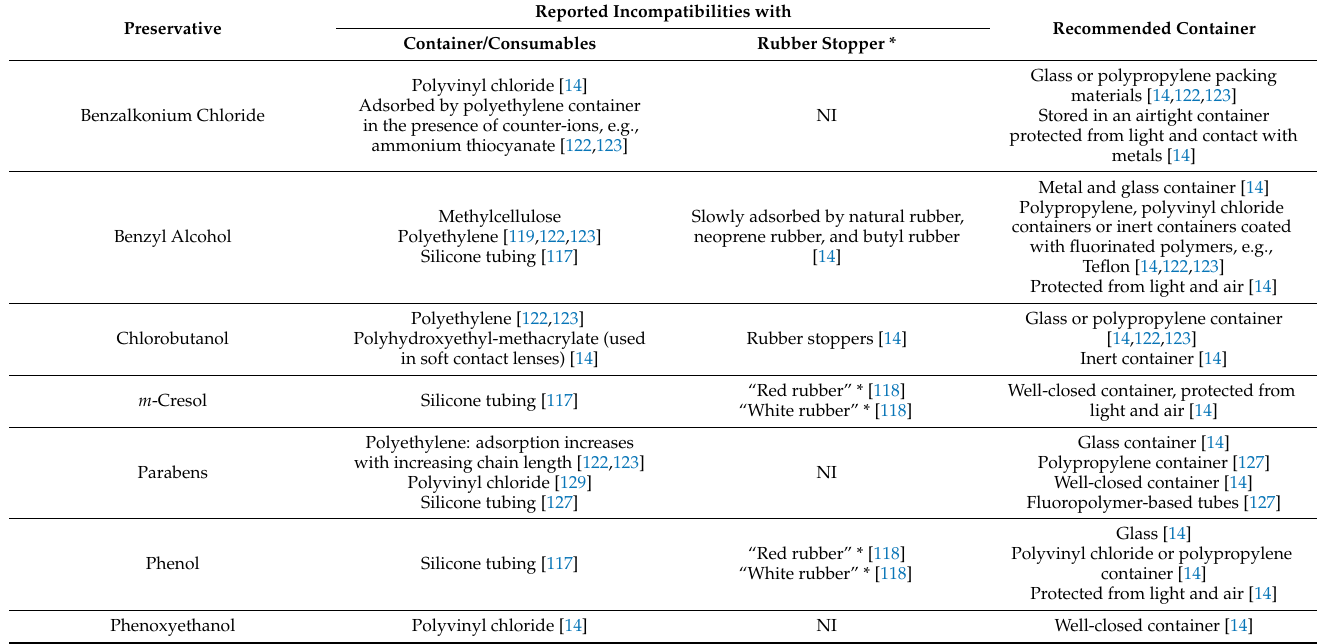
Table 11. Summary of the reported incompatibilities of antimicrobial agents with packaging mate- rial. Additionally, recommended containers and storage conditions are listed [14,117,118,127–129]. Abbreviation: NI = no